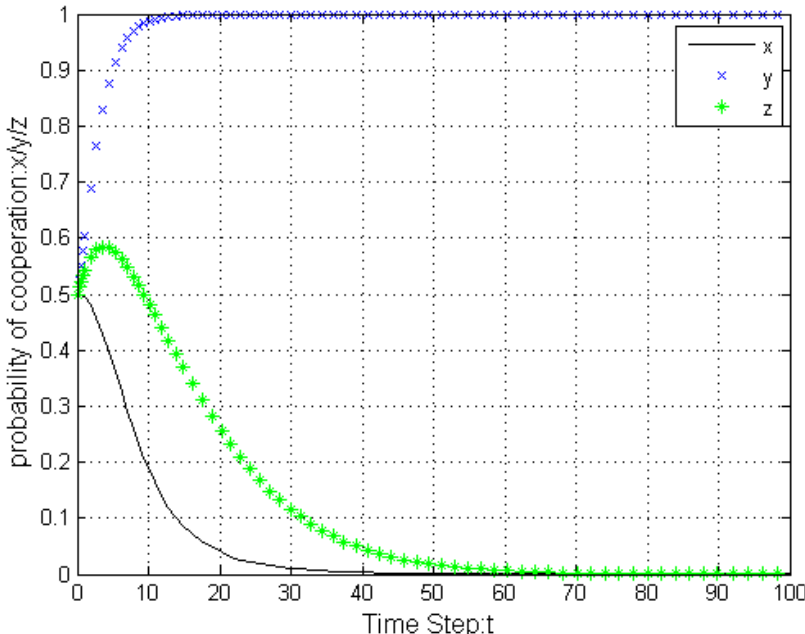
Figure 5. Evolution simulation, Scenario 5.